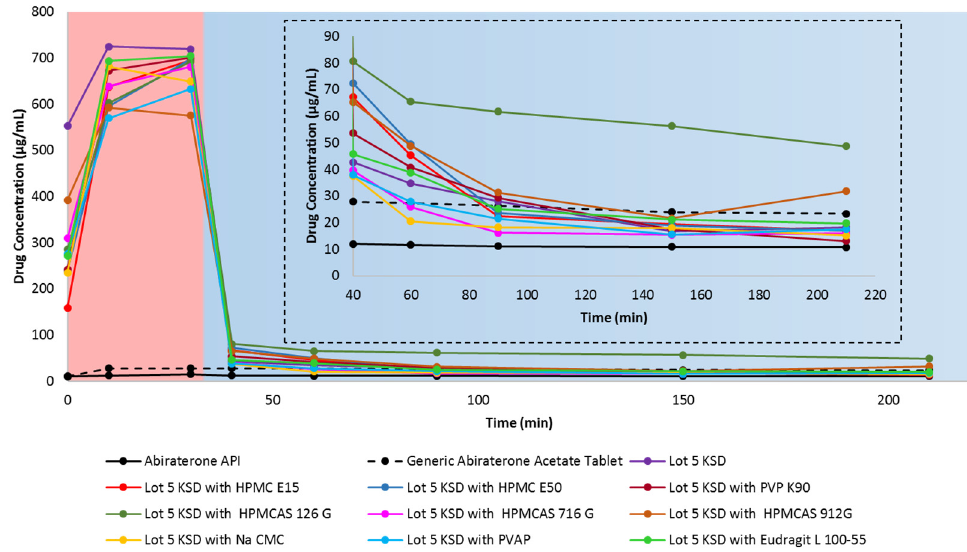
Figure 6. In vitro, non-sink, gastric transfer dissolution profile of abiraterone API, generic abiraterone acetate tablets, Lot 5 KSD and Lot 5 KSD with different secondary polymer candidates. Red region: 0.01 N HCl. Blue region: FaSSIF. The inset represents the enlargement of the dissolution profile in FaSSIF.